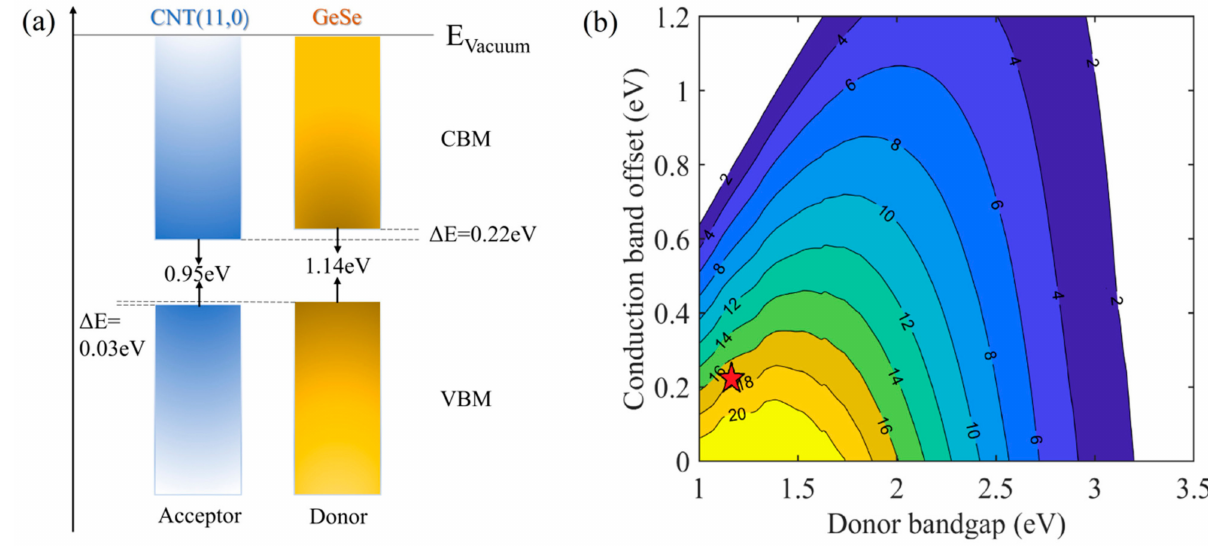
Figure 8. ( a ) Schematic representation of the band alignment of the (11,0)CNT/GeSe heterostructure. ( b ) Contour plot of power conversion efficiency (%) for the (11,0)CNT/GeSe